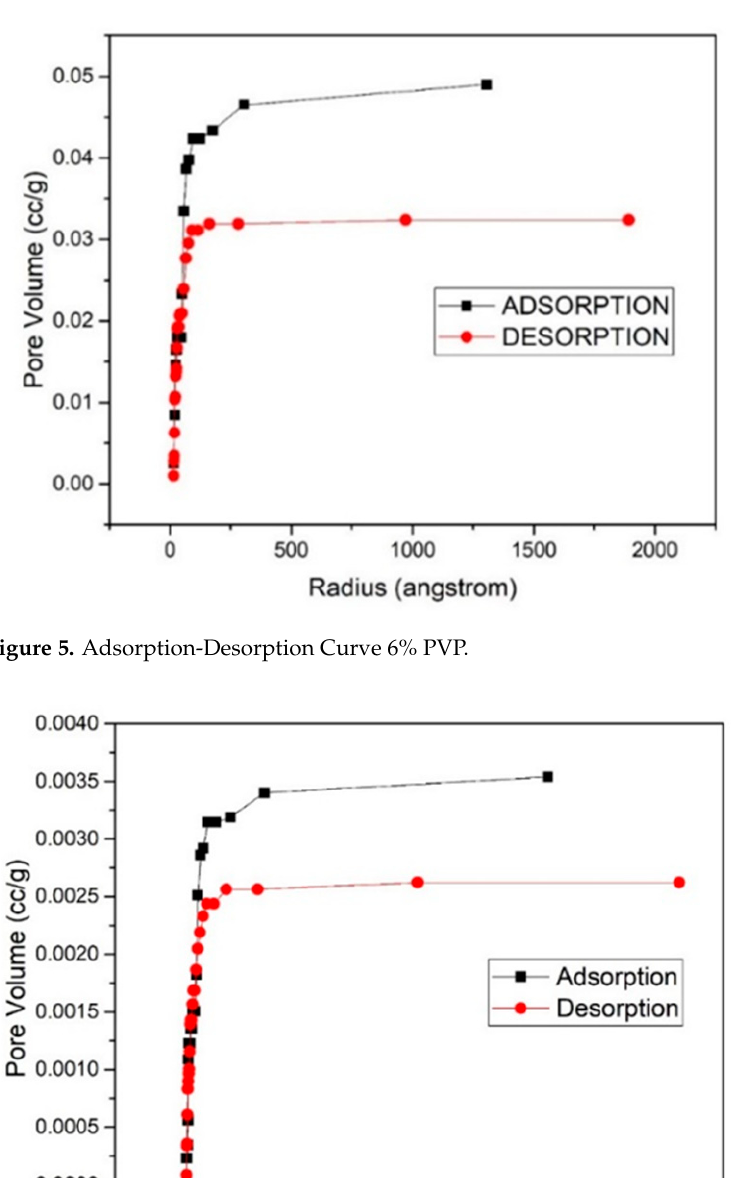
Figure 7. Adsorption-Desorption Curve 8% PVP. The pore radius vs. pore volume graph shows that maximum pores are in the range of 1–5 nm. A straight line is observed initially, showing that the maximum pore volume